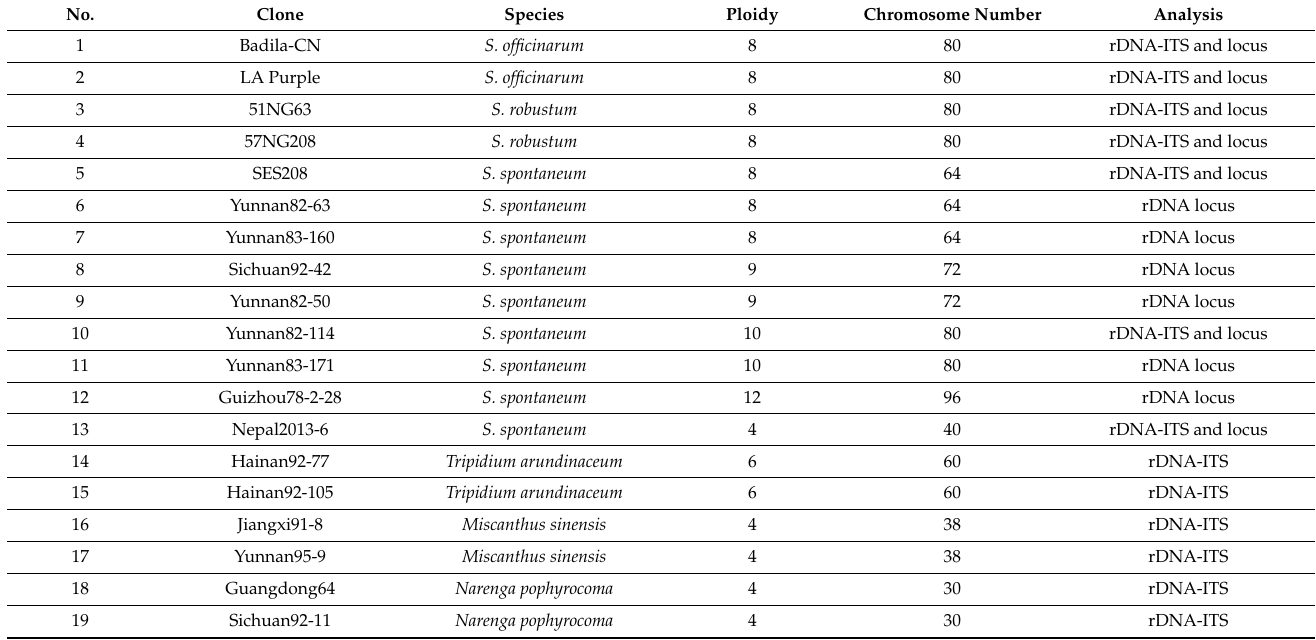
Table 1. Plant materials used in this